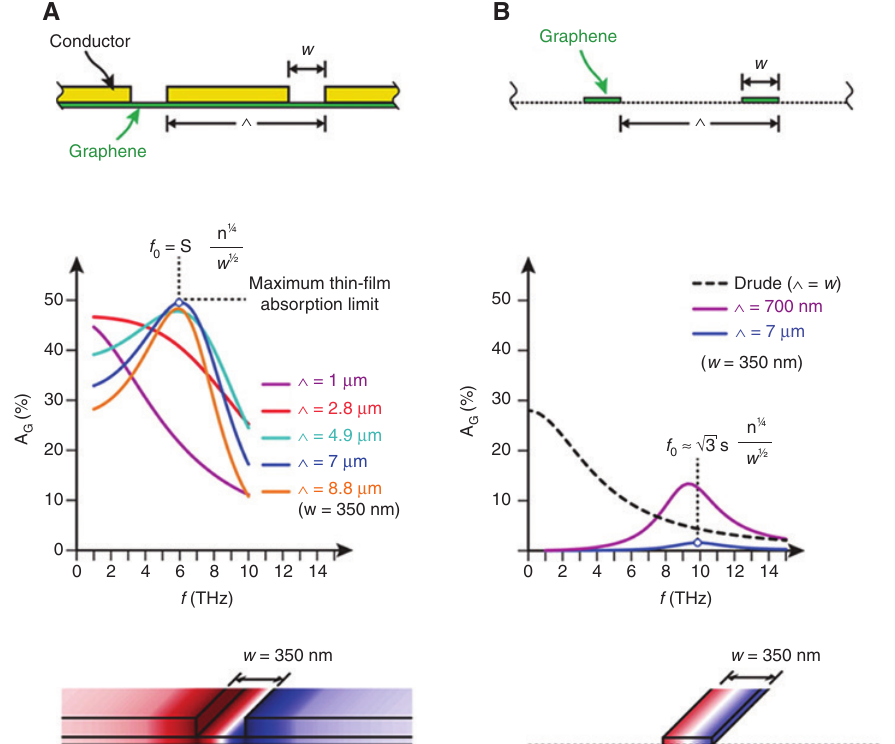
Figure 9: (A) Schematic of the hybrid structure composed of metallic conductor grating shorted by subwavelength graphene areas and the corresponding bare graphene ribbons (B). Both designs support surface plasmon resonances following similar trends by varying size and carrier concentration, but with different absorption and interaction with the incident radiation. (Reprinted and adapted with permission from Jadidi MM, Sushkov AB, Myers-Ward RL et al. Tunable terahertz hybrid Metal-Graphene Plasmons. Nano Lett. 2015, 15, 7099–7104, Ref. [79]. Copyright 2015 American Chemical Society).